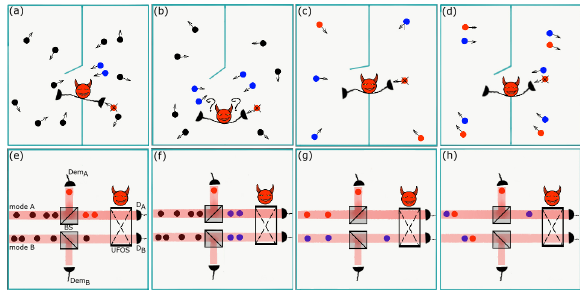
Figure 1. Principle of operation of the photonic Maxwell’s Demon (MD): the MD controls the path of particles / photons in the system. The colours red and blue represent correlated pho- tons; i.e. when the demon measures a red particle, it learns the location of the blue particle. Top row, particle picture of the pho- tonic MD; bottom row, actual implementation of the photonic MD. (a) and (e) , uncorrelated thermal states; (b) and (f) , split thermal states; (c) and (g) correlated states; (d) and (h) , anti- correlated states. Figure from